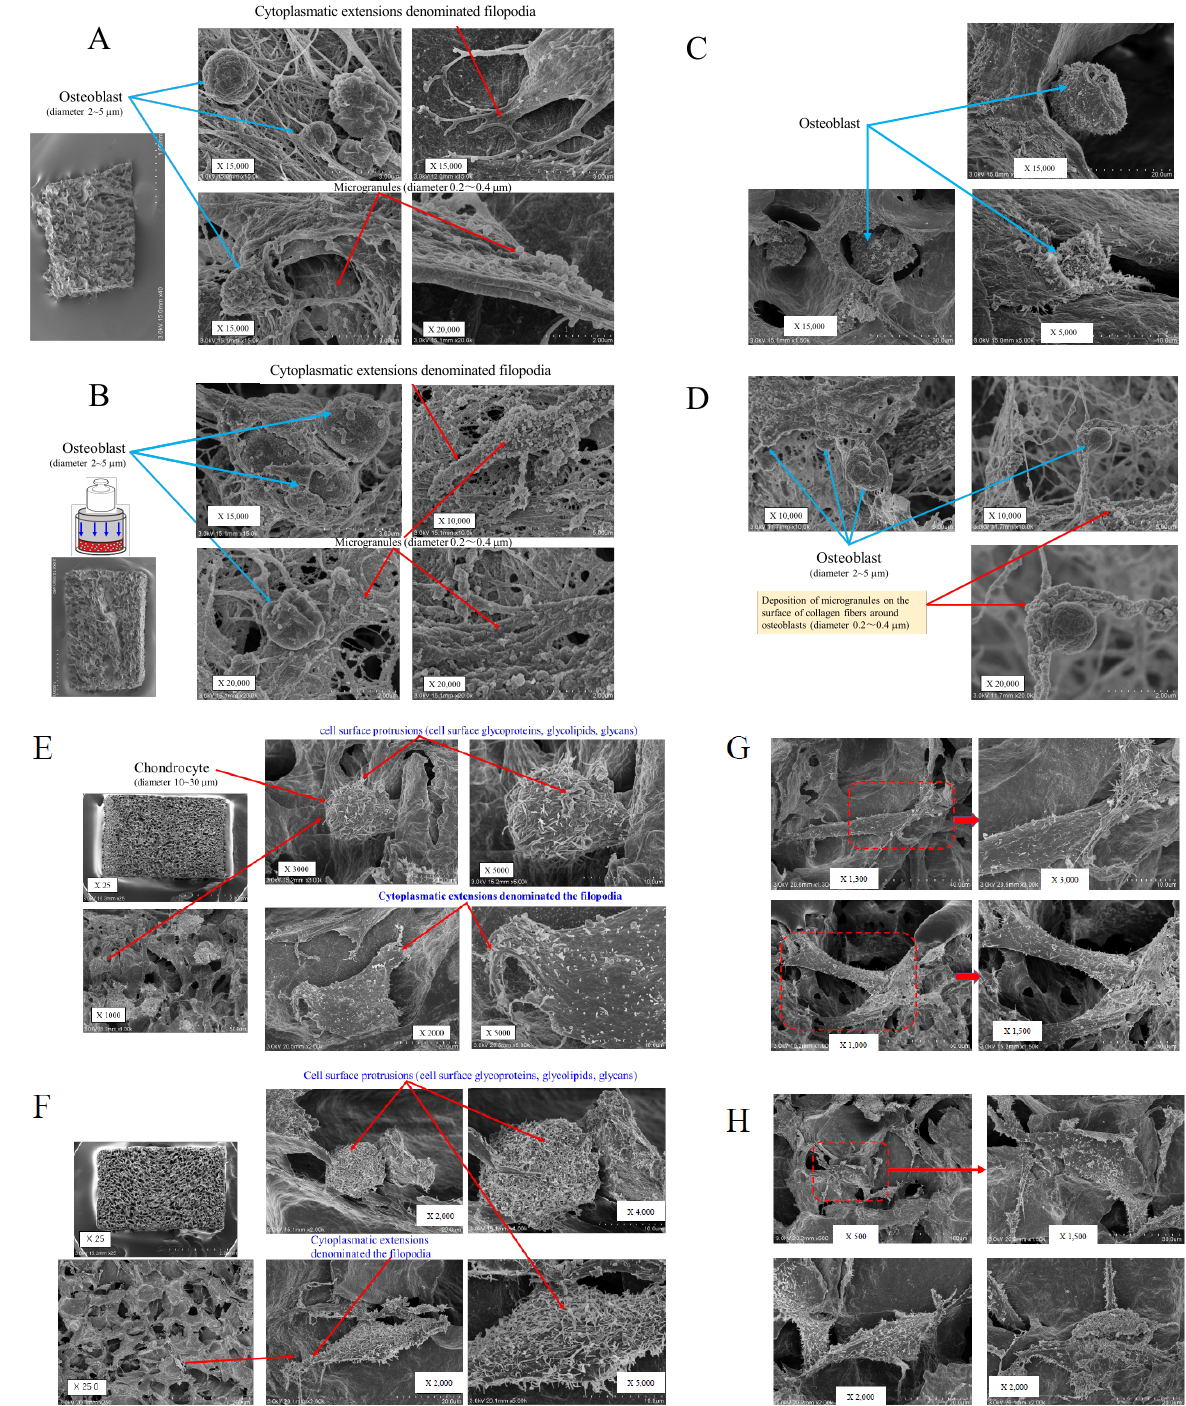
Figure 2. Scanning electron microscopy (SEM) of the 3D cell–collagen scaffold construct. Representative SEM images: ( A ) the 3D osteoblast–collagen scaffold construct (non-loading), ( B ) the 3D osteoblast–collagen scaffold construct (after 24 h mechanical loading), ( C ) the 3D osteoblast–collagen scaffold construct (after 48 h non-loading), and ( D ) the 3D osteoblast– collagen scaffold construct (after 48 h mechanical loading). ( E ) Representative SEM images of a 3D chondrocyte–collagen scaffold construct (non-loading), ( F ) the 3D chondrocyte–collagen scaffold construct (after 24 h mechanical loading), ( G ) the 3D chondrocyte–collagen scaffold construct (48 h non-loading), and ( H ) the 3D chondrocyte–collagen scaffold construct (after 48 h mechanical loading) (each subgroup/time point, n = 12).